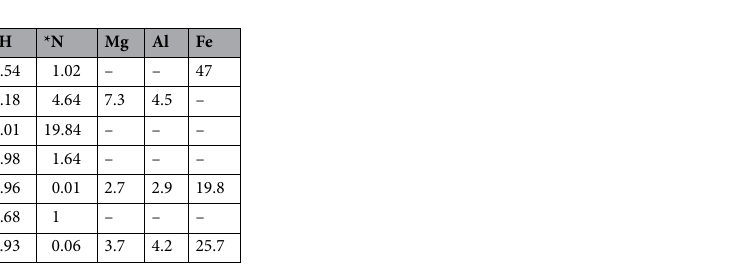
Table 2. Elemental composition of the nanoparticles obtained from CHNS and ICP-OES analyzers.